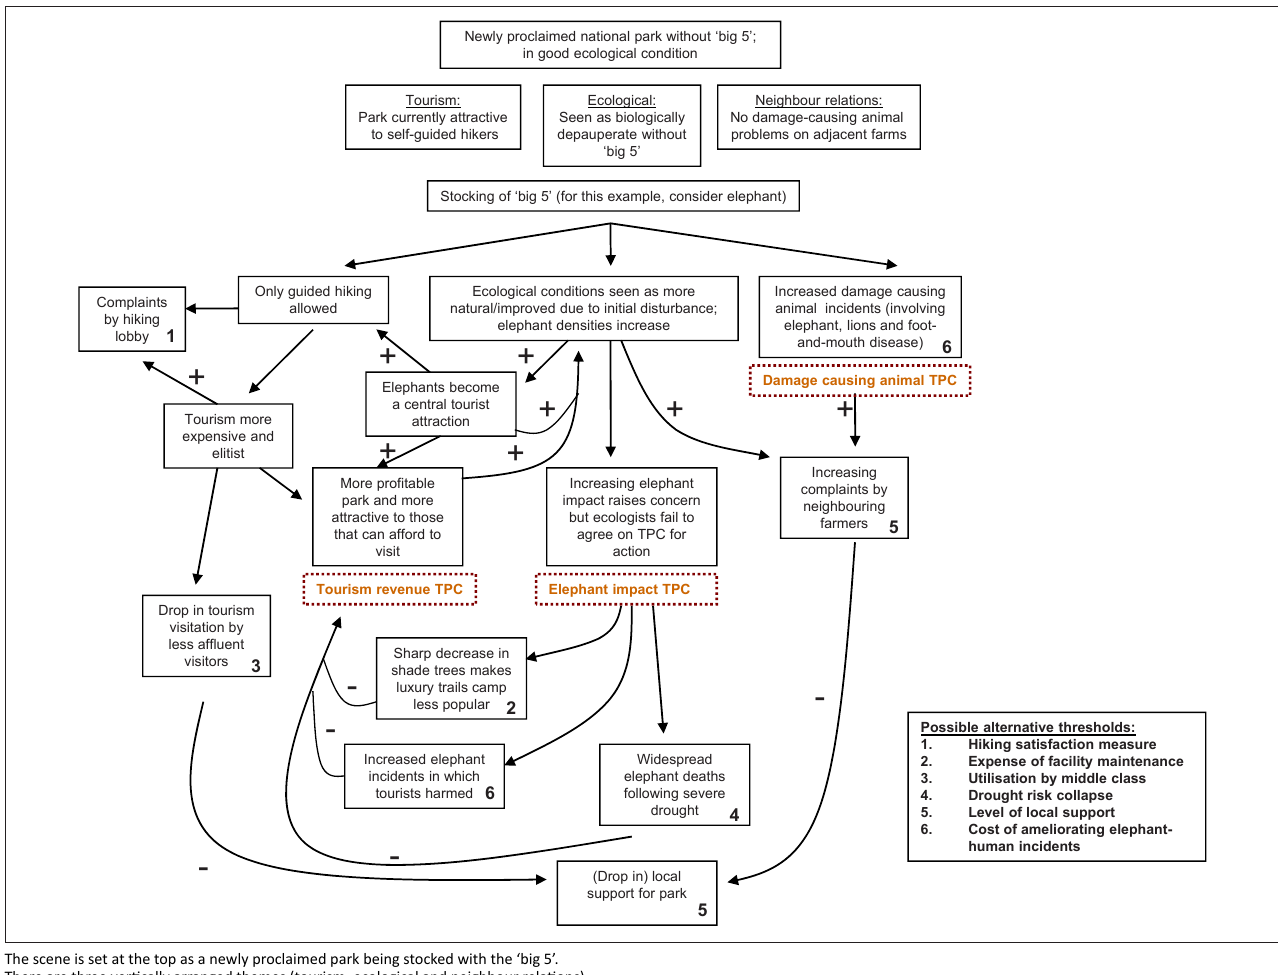
FIGURE 3: An illustrative cause-and-effect diagram showing how inter-related social and biophysical themes are a typical issue in park management. straightforward for management to handle. Our